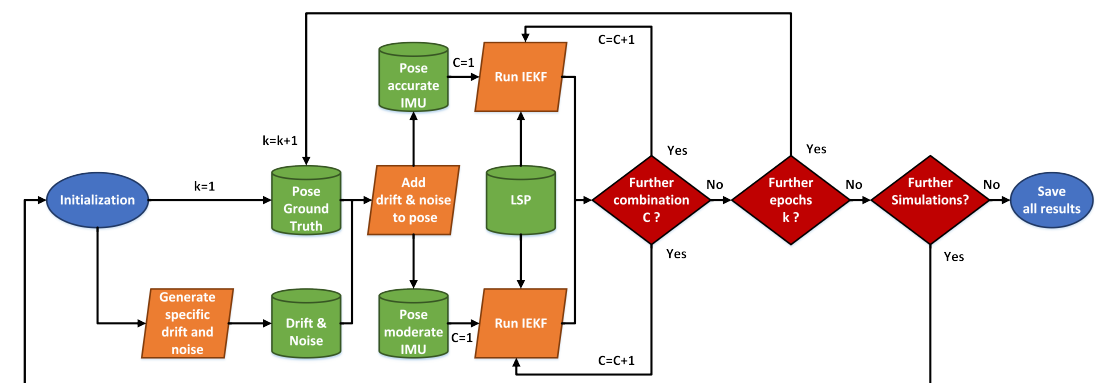
Figure 5. Schematic overview of the 500 replications performed for two types of IMUs as required input data for the iterated extended Kalman filter (IEKF) from Section 2.1 and its related combination C = I . . . X of applied state constraints. The Roman numerals refer to respective state constraints applied regarding Table 3.